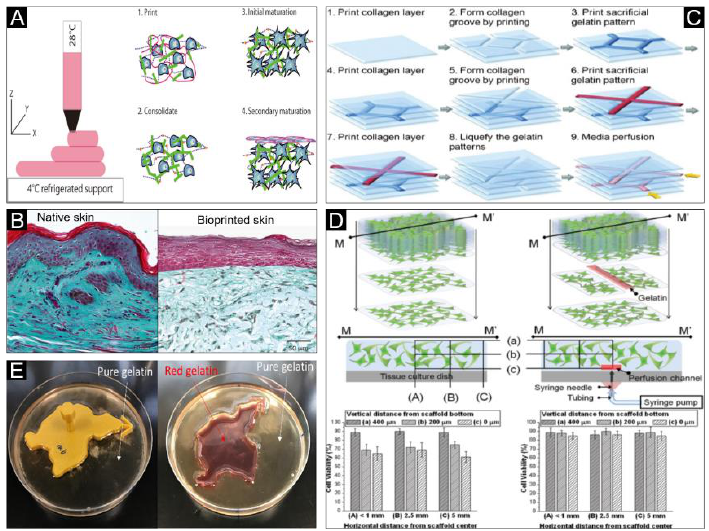
Figure 6. Thermo-sensitive bioink for skin bioprinting. ( A ) Schematic representation of the 3D bioprinting, consolidation and maturation steps using the developed bioink. ( B ) Histological and morphological characterization of native skin and the bioprinted skin. Reproduced with permission from [152]; copyright Wiley-VCH, 2016. ( C ) Schematic procedure of the construction of the multi-layered collagen scaffold with embedding and removal of sacrificial gelatin patterns using the 3D bio-printer. ( D ) Top: Schematics of fibroblast (FB)-laden collagen scaffold construction without (top, left) and with (top, right) embedding and removal of printed sacrificial gelatin channel. Middle: FB viability inspected locations (a vertical section at M–M’) in the collagen scaffolds without (middle, left) and with (middle, right) inside media perfusion. Bottom: Measured FB viability at the inspected locations after 1 week of culture without and with media perfusion. Reproduced with permission from [153]; copyright Wiley Periodicals, 2009. ( E ) Cast pure gelation and red gelatin placed in 4 °C for gelation. Reproduced with permission from [27]; copyright Elsevier, 2018.